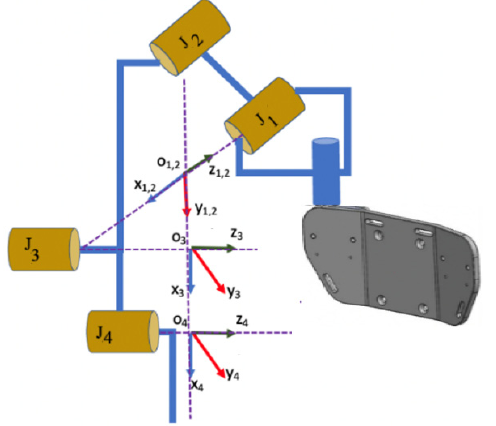
Figure 1. Review of wheelchair upper-limb exoskeleton robot system.